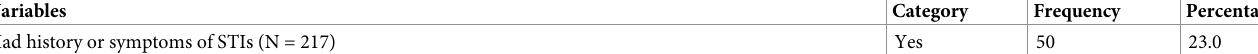
Table 5. Sexually transmitted infections and HIV testing history of spousal partners of index cases in Sodo Town, Southern Ethiopia, 2021 (N = 217).